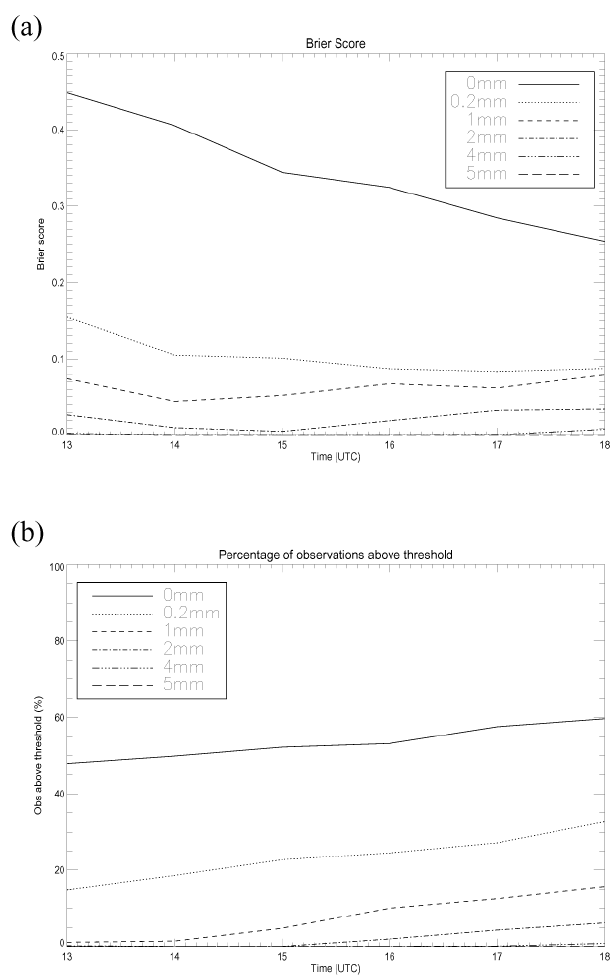
Fig. 13. (a) Brier score for the control ensemble for hourly rain accumulation, calculated using model and radar data resampled to a 13.5km grid. (b) shows the number of observation data points exceeding each rain accumulation